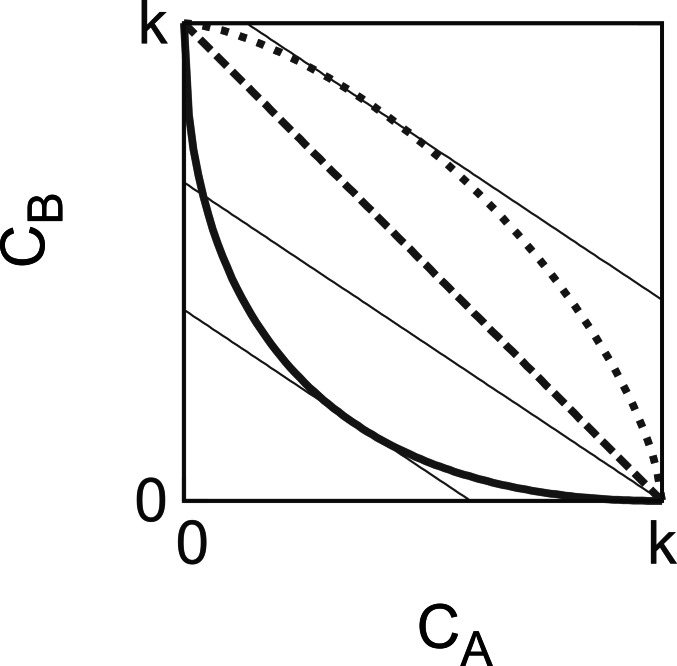
The characteristic trade-offs and cost-minimisation.The thick lines are the trade-off curves for α = 0.5 (solid), α = 1.0 (dashed) and α = 1.5 (dotted). In general, trade-off curves are convex for α < 1 and concave for α > 1. Thin lines represent iso-\documentclass[12pt]{minimal}
\usepackage{amsmath}
\usepackage{wasysym}
\usepackage{amsfonts}
\usepackage{amssymb}
\usepackage{amsbsy}
\usepackage{upgreek}
\usepackage{mathrsfs}
\setlength{\oddsidemargin}{-69pt}
\begin{document}
}{}$\overline{c}$\end{document}c¯ lines of given q values (here q = 0.4). Higher the position of a line, the larger average cost, \documentclass[12pt]{minimal}
\usepackage{amsmath}
\usepackage{wasysym}
\usepackage{amsfonts}
\usepackage{amssymb}
\usepackage{amsbsy}
\usepackage{upgreek}
\usepackage{mathrsfs}
\setlength{\oddsidemargin}{-69pt}
\begin{document}
}{}$\overline{c}$\end{document}c¯, it means. As we are looking for the lowest \documentclass[12pt]{minimal}
\usepackage{amsmath}
\usepackage{wasysym}
\usepackage{amsfonts}
\usepackage{amssymb}
\usepackage{amsbsy}
\usepackage{upgreek}
\usepackage{mathrsfs}
\setlength{\oddsidemargin}{-69pt}
\begin{document}
}{}$\overline{c}$\end{document}c¯, we look for the lowest points where these iso-\documentclass[12pt]{minimal}
\usepackage{amsmath}
\usepackage{wasysym}
\usepackage{amsfonts}
\usepackage{amssymb}
\usepackage{amsbsy}
\usepackage{upgreek}
\usepackage{mathrsfs}
\setlength{\oddsidemargin}{-69pt}
\begin{document}
}{}$\overline{c}$\end{document}c¯ lines touch the trade-off curves at least in one point. For α < 1, we get the minimal \documentclass[12pt]{minimal}
\usepackage{amsmath}
\usepackage{wasysym}
\usepackage{amsfonts}
\usepackage{amssymb}
\usepackage{amsbsy}
\usepackage{upgreek}
\usepackage{mathrsfs}
\setlength{\oddsidemargin}{-69pt}
\begin{document}
}{}$\overline{c}$\end{document}c¯ where the iso-\documentclass[12pt]{minimal}
\usepackage{amsmath}
\usepackage{wasysym}
\usepackage{amsfonts}
\usepackage{amssymb}
\usepackage{amsbsy}
\usepackage{upgreek}
\usepackage{mathrsfs}
\setlength{\oddsidemargin}{-69pt}
\begin{document}
}{}$\overline{c}$\end{document}c¯ line is a tangent of the concave trade-off curve, the coordinates of the one common point define the optimal cA and cB. The maximal extremum we get where the iso-\documentclass[12pt]{minimal}
\usepackage{amsmath}
\usepackage{wasysym}
\usepackage{amsfonts}
\usepackage{amssymb}
\usepackage{amsbsy}
\usepackage{upgreek}
\usepackage{mathrsfs}
\setlength{\oddsidemargin}{-69pt}
\begin{document}
}{}$\overline{c}$\end{document}c¯ line is a tangent of the convex trade-off curve. For α ≥ 1, the minimum is one of the endpoints of the scale.